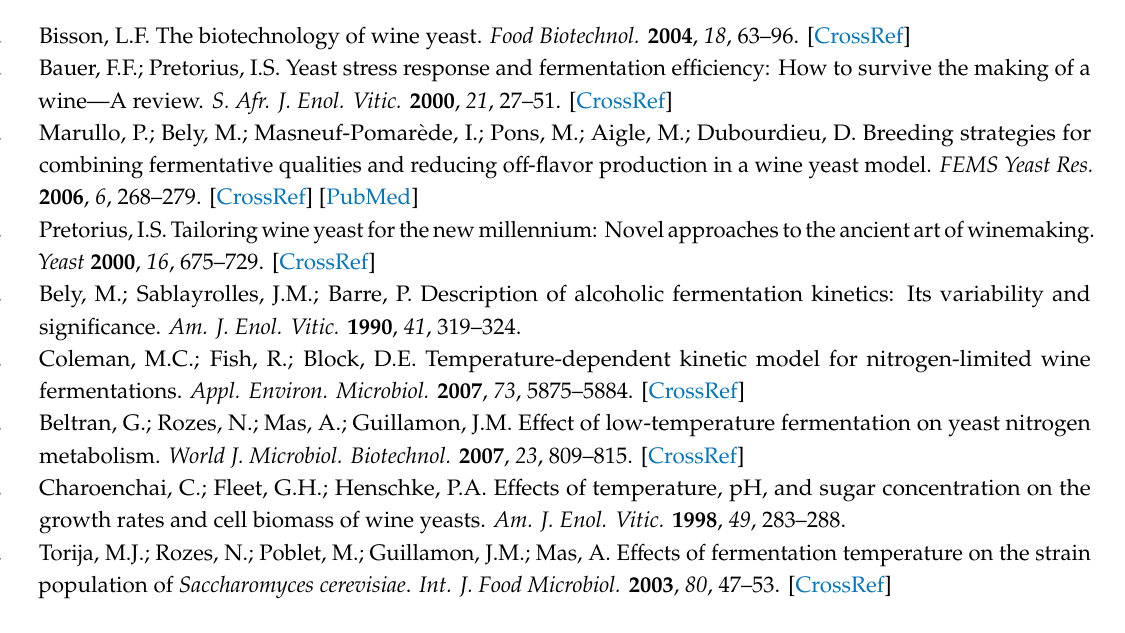
temperature on fermentation lag time, Table S6: Pairwise comparisons investigating the e ff ect of yeast lineage on fermentation lag time with FDR correction ( p -value < 0.05 = statistically significant), Figure S9: Interaction plot visualizing the interaction e ff ects between lineage and fermentation temperature on fermentation lag time, Table S7: Pairwise comparisons investigating the e ff ect of yeast continent on fermentation lag time with FDR correction. ( p -value < 0.05 = statistically significant), Figure S10: Interaction plot visualizing the interaction e ff ects between continent and fermentation temperature on fermentation lag time, Table S8: Pairwise comparisons investigating the e ff ect of yeast strain on fermentation lag time with FDR correction, Figure S11: Interaction plot visualizing the interaction e ff ects between yeast strain and fermentation temperature on fermentation lag time, Table S9: Pairwise comparisons investigating the e ff ect of yeast lifestyle on fermentation V max with FDR correction. ( p -value < 0.05 = statistically significant), Figure S12: Interaction plot visualizing the interaction e ff ects between lifestyle and fermentation temperature on fermentation V max , Table S10: Pairwise comparisons investigating the e ff ect of yeast lineage on fermentation V max with FDR correction ( p -value < 0.05 = statistically significant), Figure S13: Interaction plot visualizing the interaction e ff ects between lineage and fermentation temperature on fermentation V max , Table S11: Pairwise comparisons investigating the e ff ect of yeast continent of origin on fermentation V max with FDR correction. ( p -value < 0.05 = statistically significant), Figure S14: Interaction plot visualizing the interaction e ff ects between continent and fermentation temperature on fermentation V max , Table S12: Pairwise comparisons investigating the e ff ect of yeast strain on fermentation V max with FDR correction, Figure S15: Interaction plot visualizing the interaction e ff ects between yeast and fermentation temperature on fermentation V max , Table S13: Pairwise comparisons investigating the e ff ect of yeast lifestyle on fermentation e ffi ciency with FDR correction. ( p -value < 0.05 = statistically significant), Figure S16: Interaction plot visualizing the interaction e ff ects between lifestyle and fermentation temperature on fermentation e ffi ciency, Table S14: Pairwise comparisons investigating the e ff ect of yeast lineage on fermentation e ffi ciency with FDR correction. ( p -value < 0.05 = statistically significant), Figure S17: Interaction plot visualizing the interaction e ff ects between lineage and fermentation temperature on fermentation e ffi ciency, Table S15: Pairwise comparisons investigating the e ff ect of yeast continent on fermentation e ffi ciency with FDR correction. ( p -value < 0.05 = statistically significant), Figure S18: Interaction plot visualizing the interaction e ff ects between continent and fermentation temperature on fermentation e ffi ciency, Table S16: Pairwise comparisons investigating the e ff ect of yeast strain on fermentation e ffi ciency with FDR correction, Figure S19: Interaction plot visualizing the interaction e ff ects between strain and fermentation temperature on fermentation e ffi